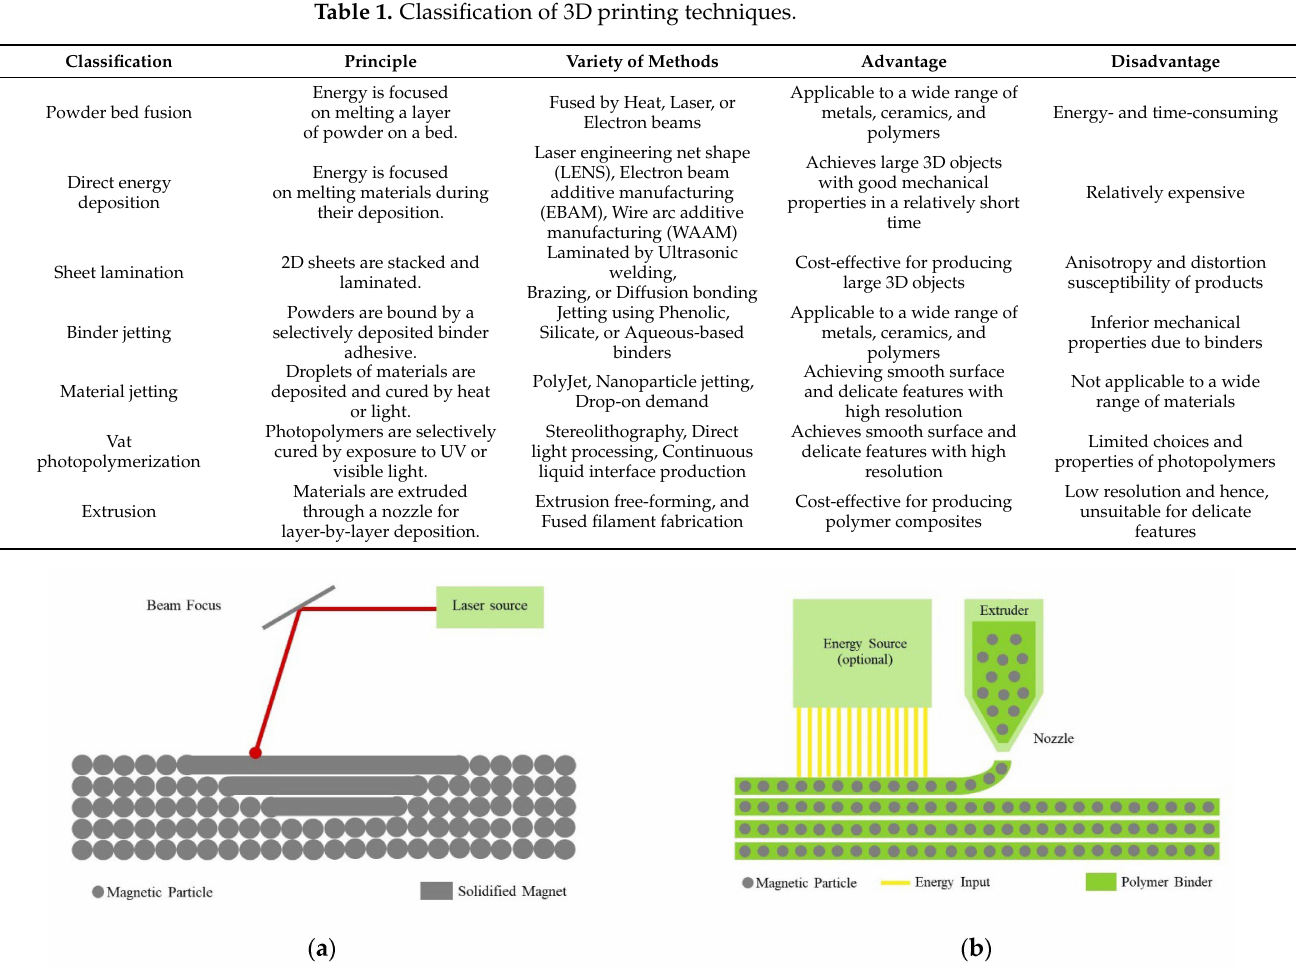
Figure 2. Examples of additive manufacturing processes for magnetic materials: ( a ) selective laser melting; ( b )